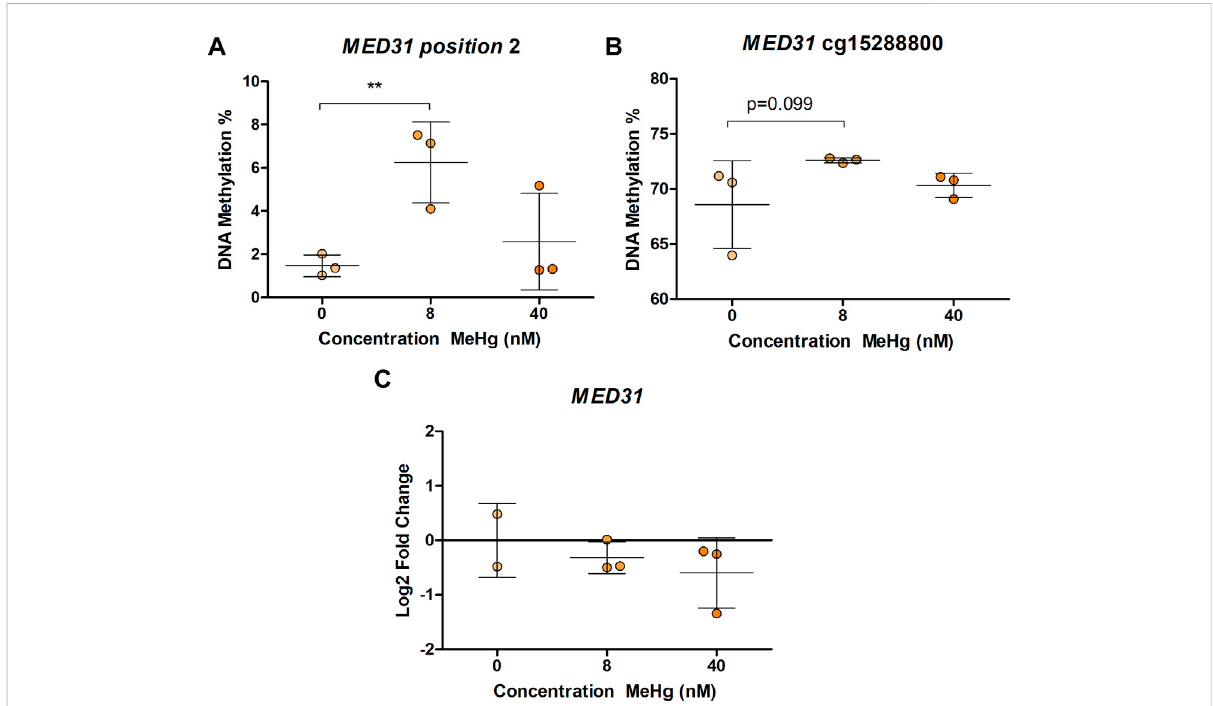
FIGURE 1 MED31 DNAmethylationandgeneexpressioninMeHg-exposedSH-SY5Ycells; (A) DNAmethylationlevelsatpositionchr17:6,555,443located 3bpfromcg24184221; (B) DNAmethylationlevelsatpositionchr17:6,555,742; (C) MED31 expressionlevels.Theresultsarepresentedasthemean± SDofthreeindependentbiologicalreplicatesandwereanalyzedwithOne-wayAnalysisofvariance(ANOVA)withDunnett ’ spost-hoctest.Statistical signi fi cance was considered when the p -value was below